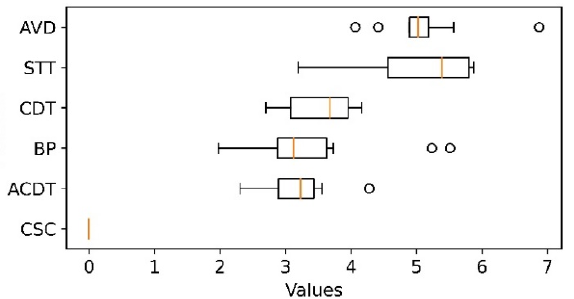
Figure 9. Feature importance by permutation depicting variable contributions to the random for- est models’ predictions. (Source: author). models’ predictions. (Source: